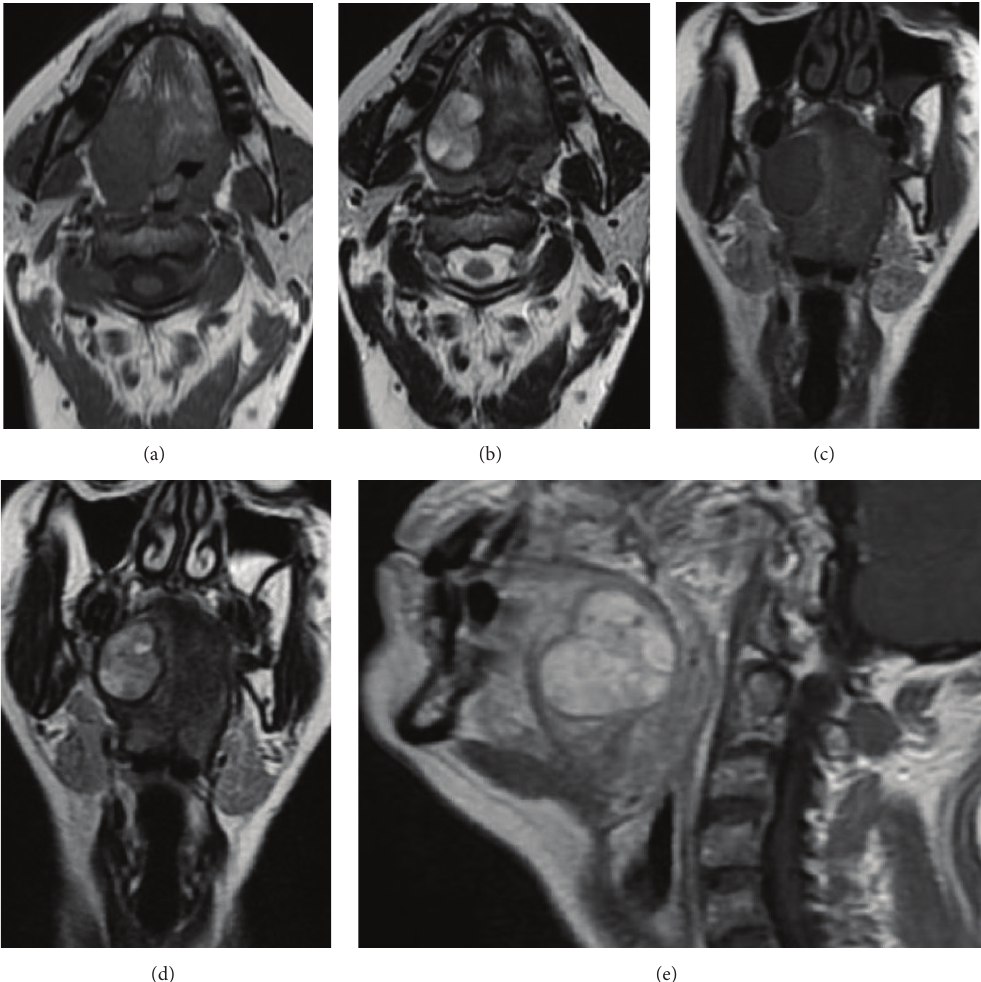
Figure 1: MRI images of axial section ((a-b), T1 and T2 weight) and coronal sections ((c-d), T1 and T2 weight); MRI images of sagittal section (e) showed the enhancing of the tumour mass involving the tongue base after gadolinium administration in T1 weight.